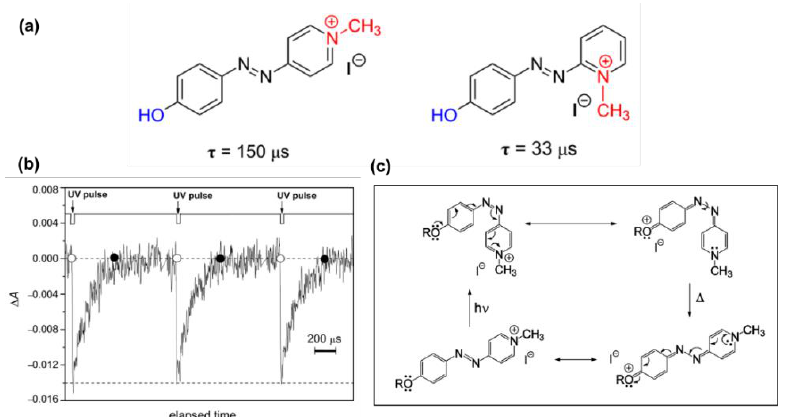
Figure 22. ( a ) Effect of the presence of a positively charged nitrogen as an electron−withdrawing group on the thermal relaxation time at 298 K, τ, for the type−I azoderivative. ( b ) Oscillation of the optical density of an ethanol solution of azo-dye generated by UV-light irradiation. ( c ) Mechanism proposed for the thermal cis -to- trans isomerization process for the azopyridinium methyl iodide salt. Reprinted with permission from [73,114]. Copyright 2010, American Chemical Society and 2011, Royal Society of Chemistry.